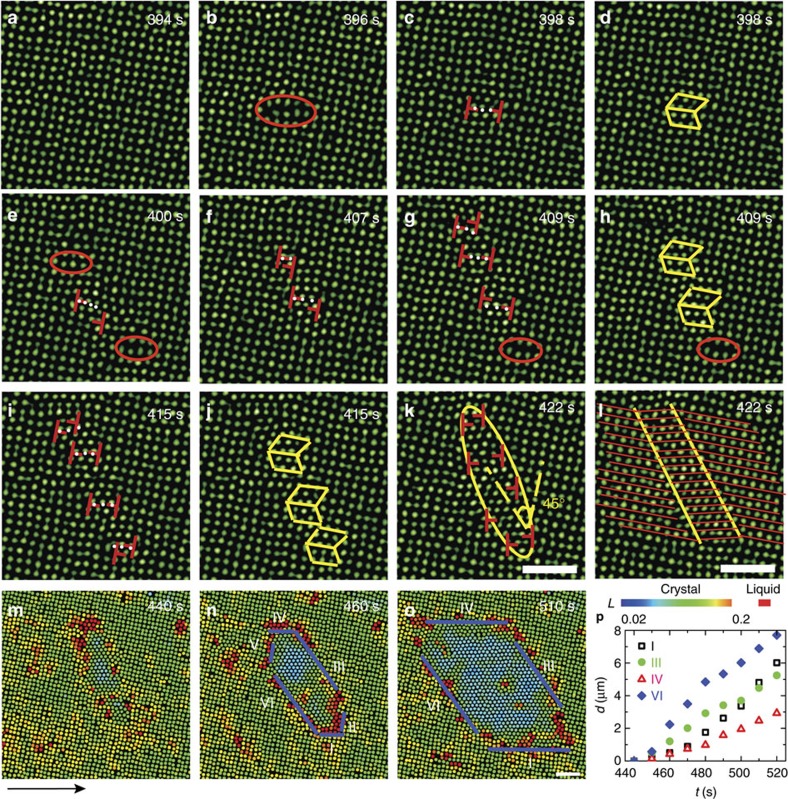
Flow-induced early-stage martensitic precursors and later-stage diffusive nucleus growth.The 5✓→4Δ transition occurred at a locally defect-free region. The generated dislocations are labelled with . The flows were along the x direction of the images (labelled by the arrow below m) and moved at ν=11 nm s−1. Optical heating commenced at t=0 s. (a–o) correspond to Supplementary Movies 1 and 2, respectively. (a) A defect-free region in the 5✓-lattice. (b) A small gap marked by the ellipse in red developed under thermal fluctuation at t=396 s. (c) A row of three particles labelled in white moved from the bulk layer to the gap in the surface layer, forming a pair of dislocations. (d) The same image as c can be viewed as a very small Δ-lattice precursor labelled by the yellow ‘butterfly'. The dislocations glided in opposite directions and oscillated at ∼0.2 Hz with an amplitude of two lattice constants, then generated new gaps and new dislocation pairs alternatively around the first pair. All the dislocation pairs were arranged in a line and oscillated in phase during the nucleation precursor stage e–i. From i–l, the dislocation pairs stopped oscillating and martensitically formed an elliptical Δ-lattice nucleus. In l, the 2 yellow lines indicated the habit planes and the 13 red lines are along the lattice orientations in the parent and product phases. The martensitic nucleus then grew in all directions through diffusion in m–o. The colour bar above p shows different values of the dynamical Lindemann parameter L used in m–o. Liquid-like particles are defined as particles with L>0.2 and low bond-orientational orders and are labelled in red23 (Methods). They swapped positions with neighbouring particles, hence they are liquid, not glass. Scale bars, 5 μm. The nucleus developed facets in n and grew into a parallelogram shape in o. The Δ-lattice had one layer less than the ✓-lattice in the z direction, hence it was more compact in the xy plane with lower Lindemann parameters and about 3% lower lattice constant as the nucleus grew larger. (m–o) Coloured by Lindemann parameter L. Red colour represents liquid-like particles, which L>0.2 and low bond-orientational order parameter (Methods)29. (p) Displacements of the four facets along their normal directions after subtracting the background flow.